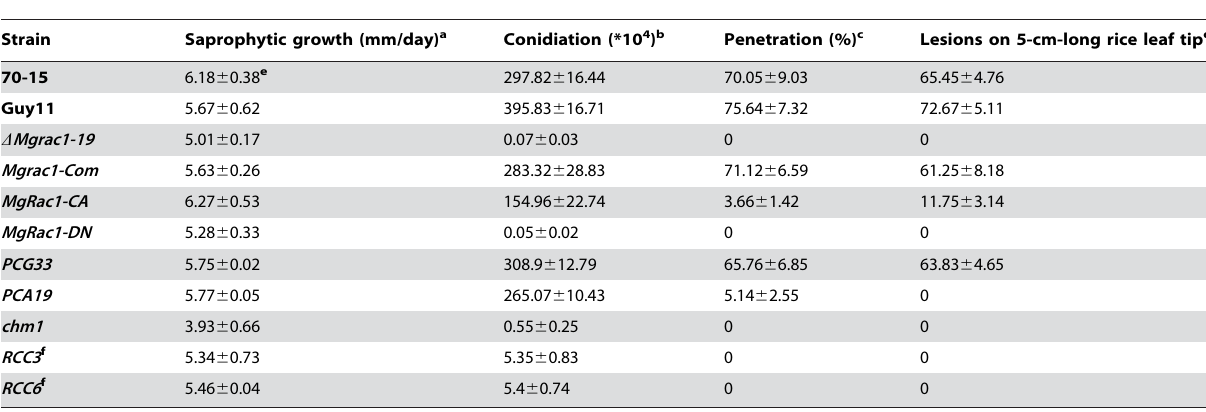
Table 1. Phenotypic analysis of MgRac1